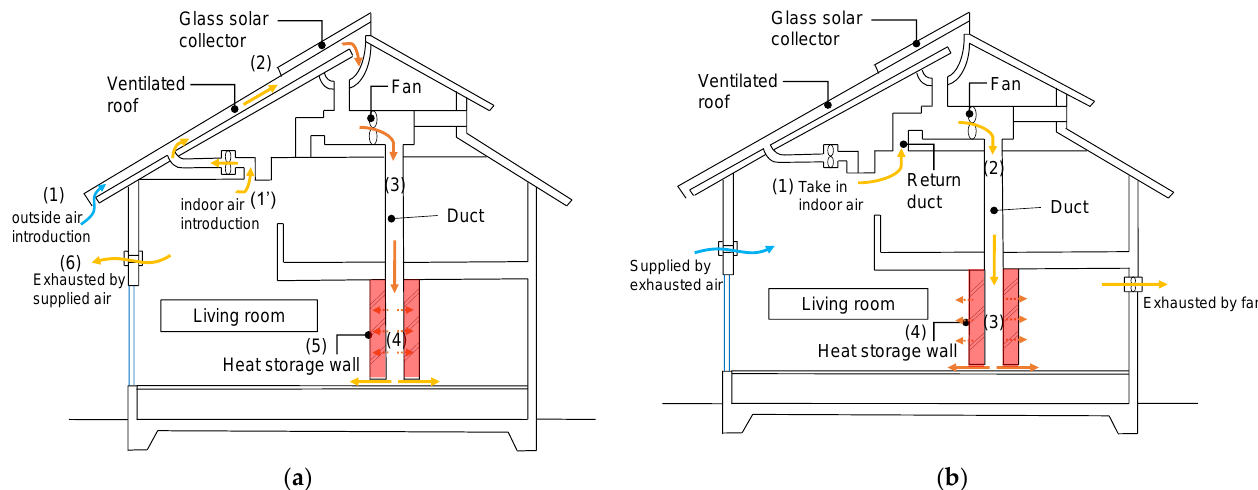
Figure 5. Air circulation route of Type C: ( a ) heat collection operation during daytime; ( b ) heat release during nighttime.